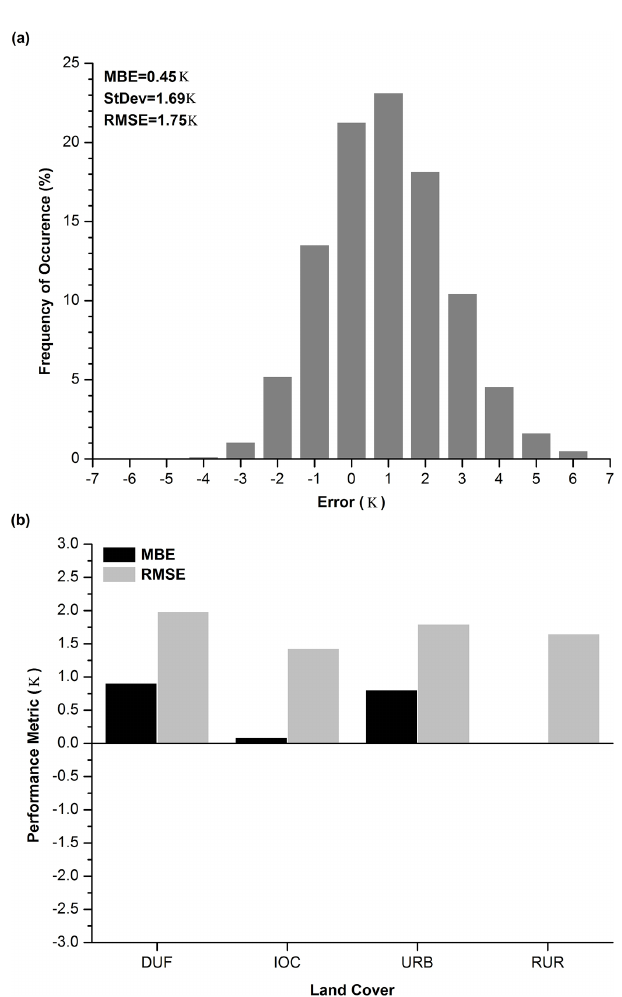
Fig. 5. (a) Distribution of errors in the modeled near-surface air temperature, and (b) model performance metrics (MBE, RMSE) for the near-surface air temperature, grouped by land use